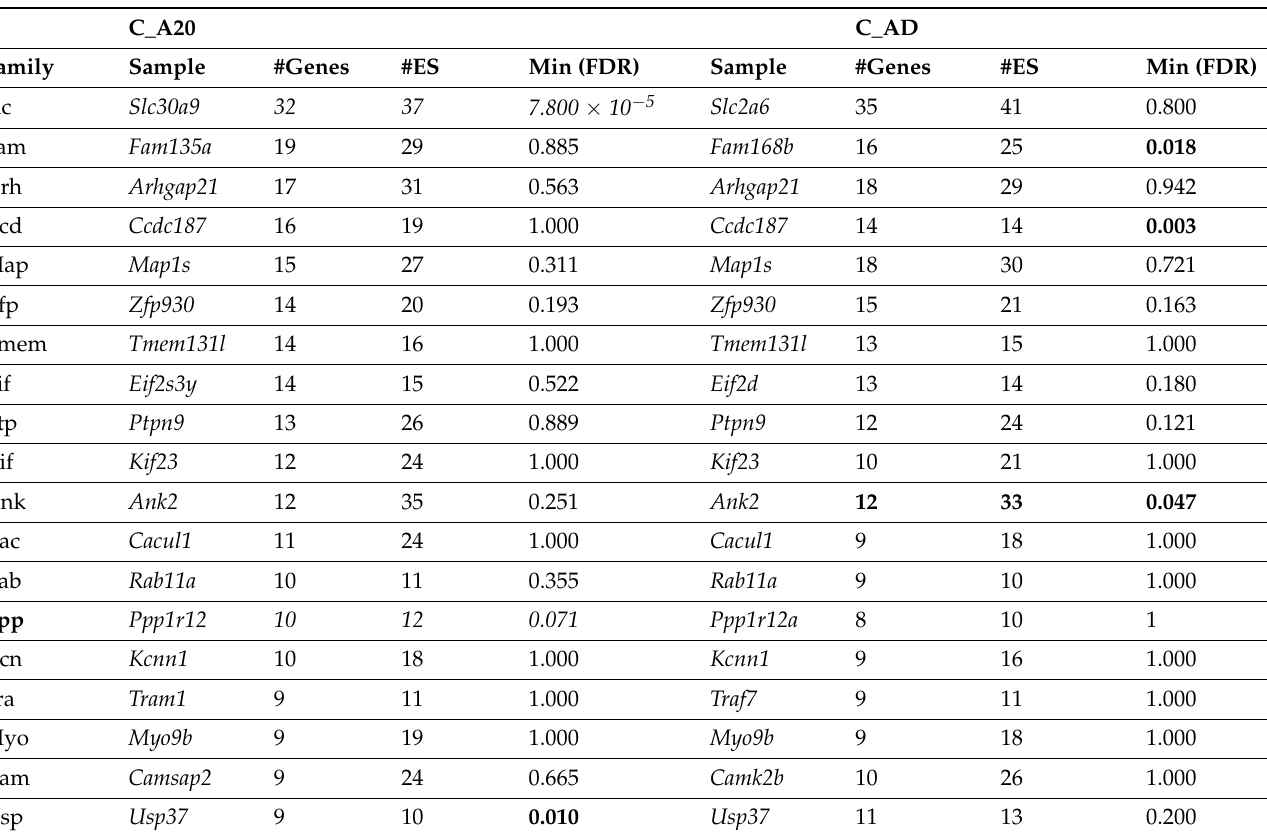
Table 6. Gene families (defined by the three first letters of the gene name) with the top number of coding ES skipping events for C_A20 and C_AD comparisons. The statistically significant events in a specific gene of the family in a particular comparison are